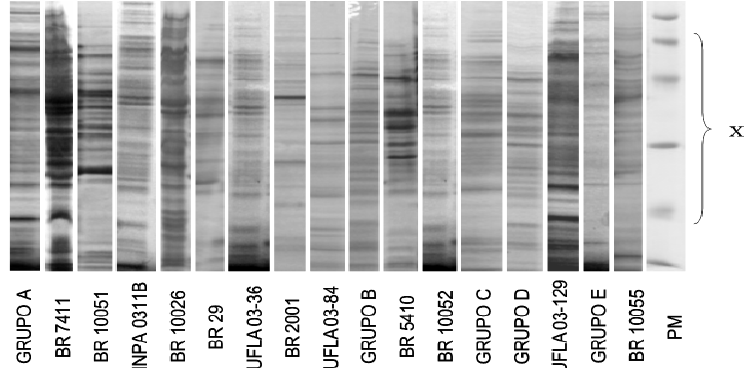
Figura 2. Perfis de proteína celular total de estirpes isoladas do solo da área em estudo, das estirpes de referências e das estirpes tipo obtidas por eletroforese em gel de poliacrilamida (SDS-PAGE). X = área utilizada – 15 bandas; PM = padrão de peso molecular